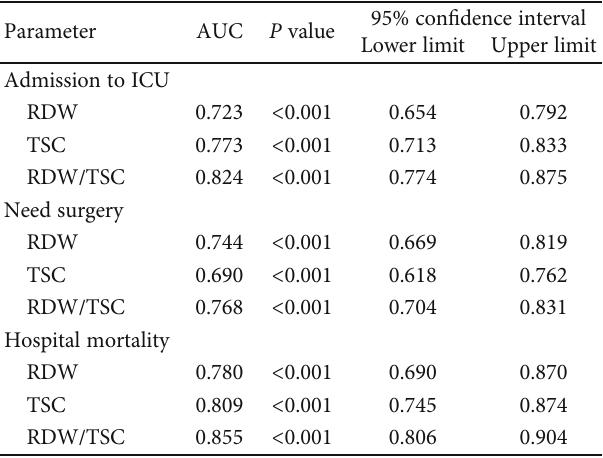
Table 3: ROC curve analysis of predicting prognosis of patients with